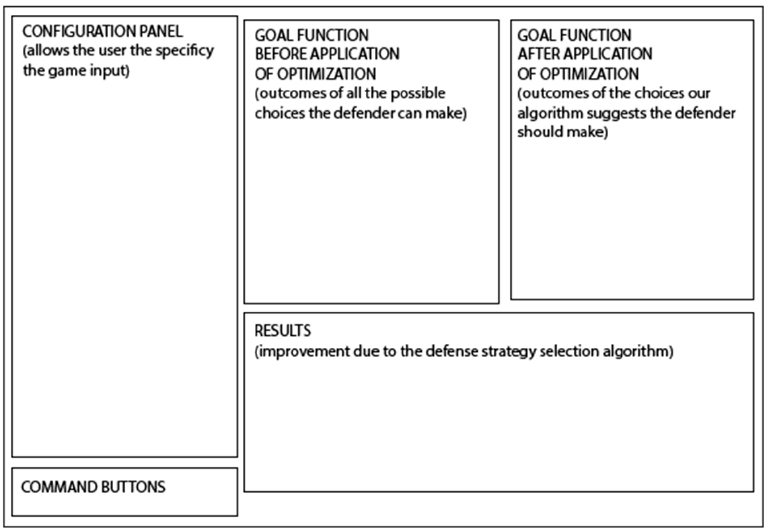
Figure 10. GUI (Graphical User Interface) layout of the Pareto Defense Strategy Selection Simulator (PDSSS) system. (PDSSS) Table 5. Dataset statistics.